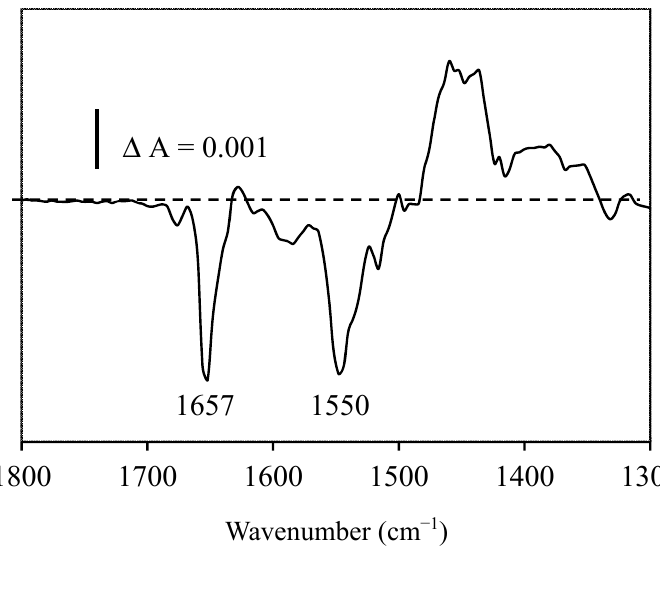
Figure 2. Infrared differential spectrum of resveratrol with BSA (the spectrum of trans resveratrol with BSA minus the spectrum of cis resveratrol with BSA) obtained after photo-isomerization in the same infrared